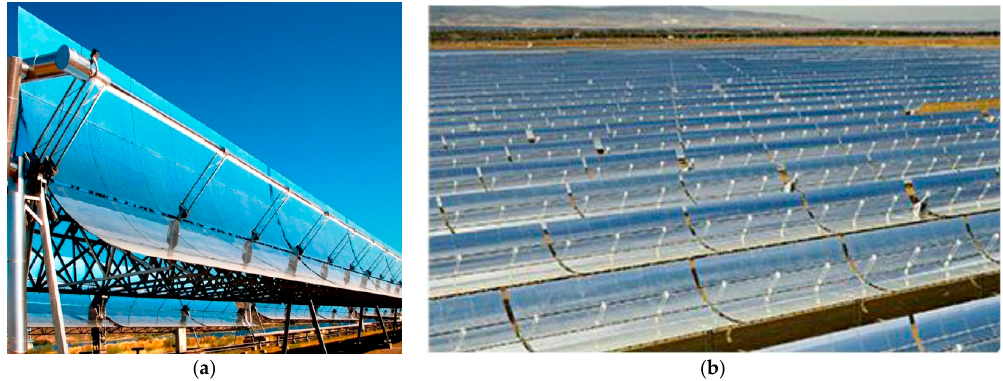
Figure 3. Concentrated Solar Power Technologies: ( a ) parabolic cylindrical collector; and ( b ) parabolic trough solar power plant—ANDALUSIA AND SOL I—ANDASOL I (50 MW, Granada, Spain). The estimative is that Concentrated Solar Power (CSP) technologies present even stronger growth in the next few years. According to International Energy Agency [4], this technology may provide 11% of worldwide demand for electricity in 2050, in a hi-Ren scenario (High Renewable Scenario), when renewable energy, solar and wind, would represent the main agents to reduce carbon dioxide emissions in the environment.